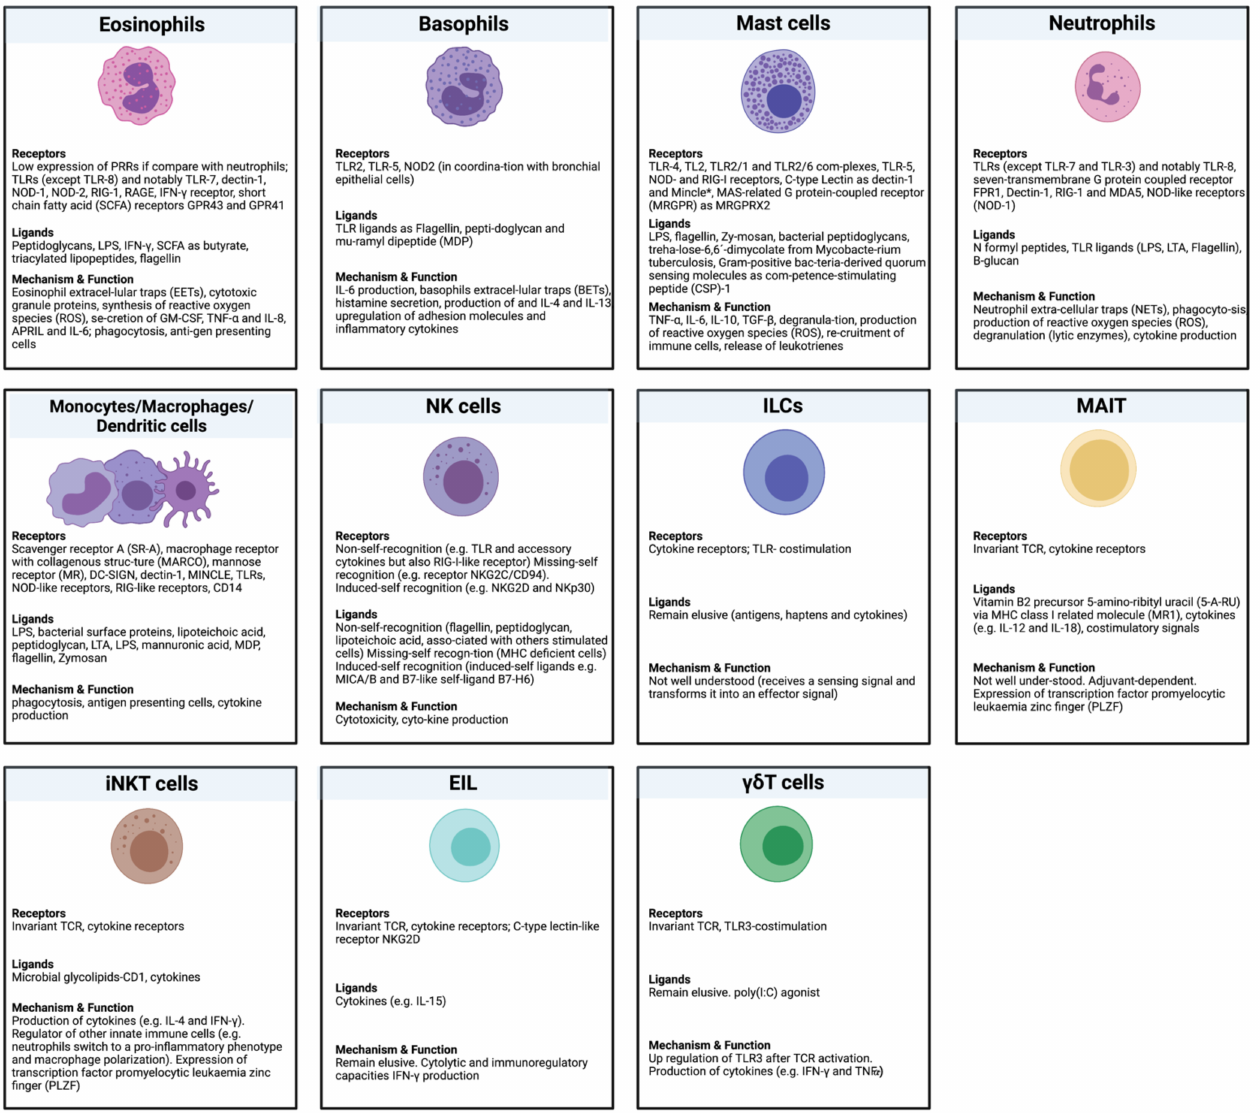
Figure 5. Principal hematopoietic actors in the innate immune response (this figure was created with Biorender.com, accessed on 20 September 2021). For more information see refs.